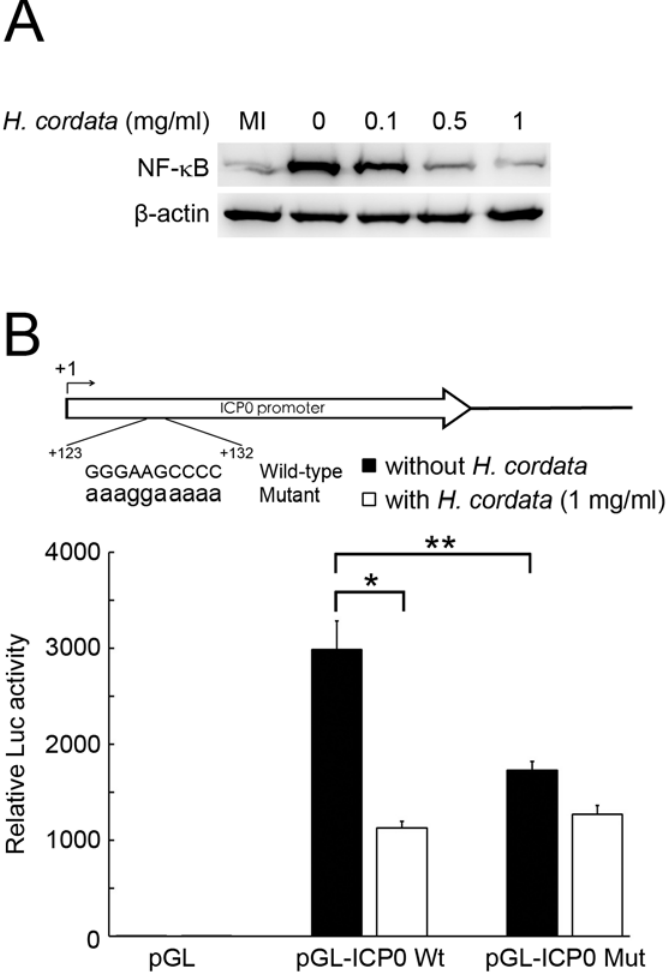
Figure 8. HCWEs eliminate HSV-1 induced NF- κ B activation and suppress ICP0 transcription. (A) HCWEs inhibited HSV-induced NF- κ B activation. 1X10 6 cells were infected with HSV-1 at 1 m.o.i. in presence of HCWEs. The nuclear fraction was extracted at 3 h.p.i. and analyzed for NF- κ B translocation. (B) HCWEs suppressed ICP0 transcription in NF- κ B-dependent manner by promoter assays. 2X10 3 cells were transfected wtih pGL reporter vectors harboring HSV-1 ICP0 promoter with wild-type (WT) or mutant (Mut) NF- κ B binding core sequence and then infected with HSV-1 at 1 m.o.i. in the presence or absence of 1 mg/ml HCWEs. The luciferase activities were measured at 24 h.p.i.. * p value < 0.05 presented comparison of pGL-ICP0 Wt in the presence or absence of HCWEs; ** p value < 0.05 presented comparison of pGL-ICP0 Wt and pGL-ICP0 Mut without